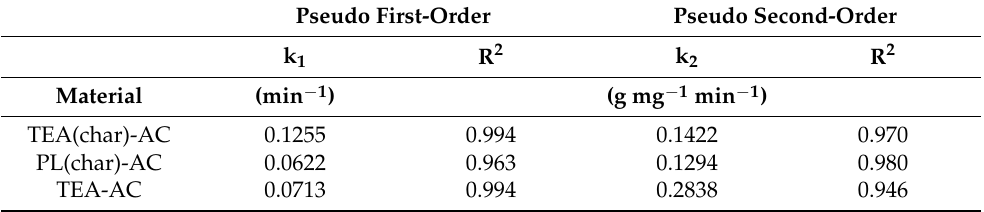
Table 3. Pseudo first-order and pseudo second-order equations for PRM uptake from aqueous solutions.